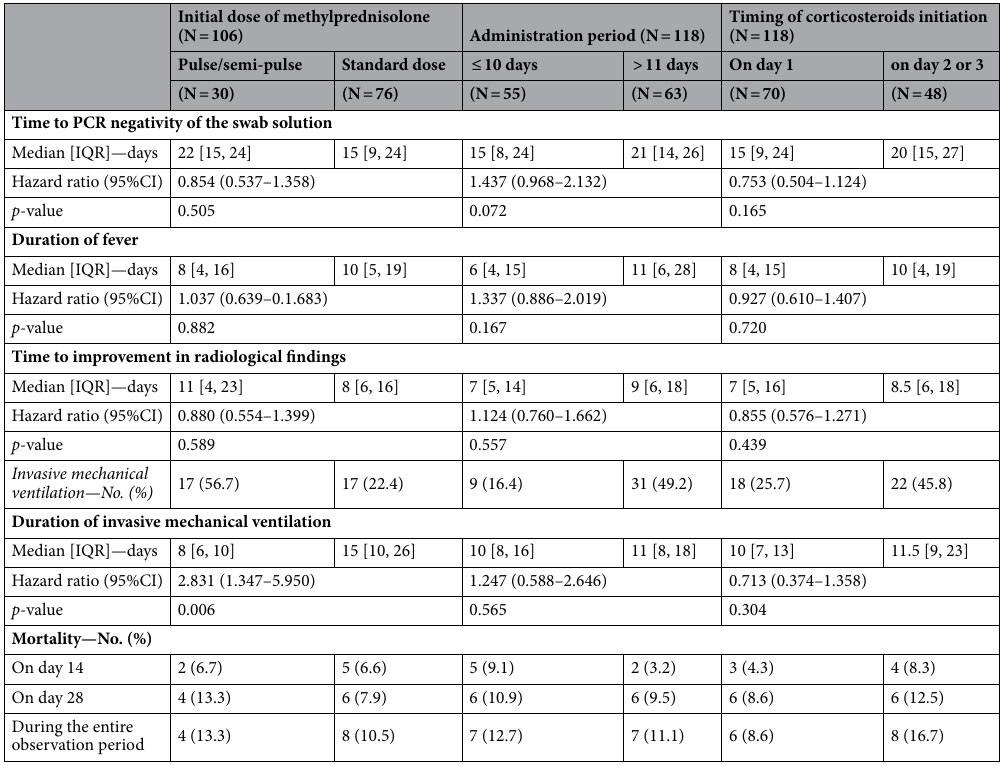
Table 5. Subgroup analysis in the propensity-score matched corticosteroid group. Categorical variables were presented as numbers (percentages). Continuous variables related to time were presented as median [interquartile ranges]. Cox proportional hazards model was used to calculate the hazard ratio and its 95% confidence interval for the treatment effect between groups. A p value of < 0.05 was considered statistically significant. IQR, interquartile ranges; CI, confidence interval; PCR, polymerase chain